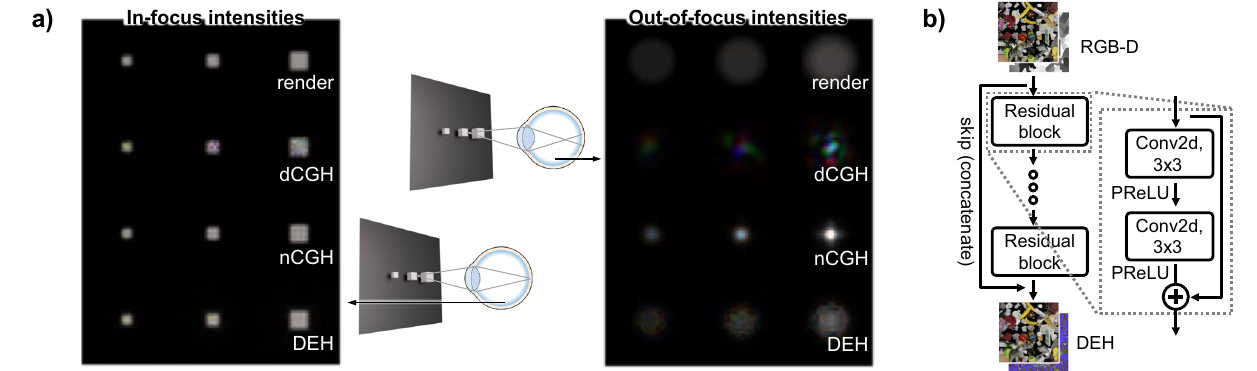
cubes are 3,4,and 6pixels(fromlefttoright). b Theconvolutionalneuralnetwork synthesizes a wave fi eld from an all-in-focus image and an all-in-focus depth map.